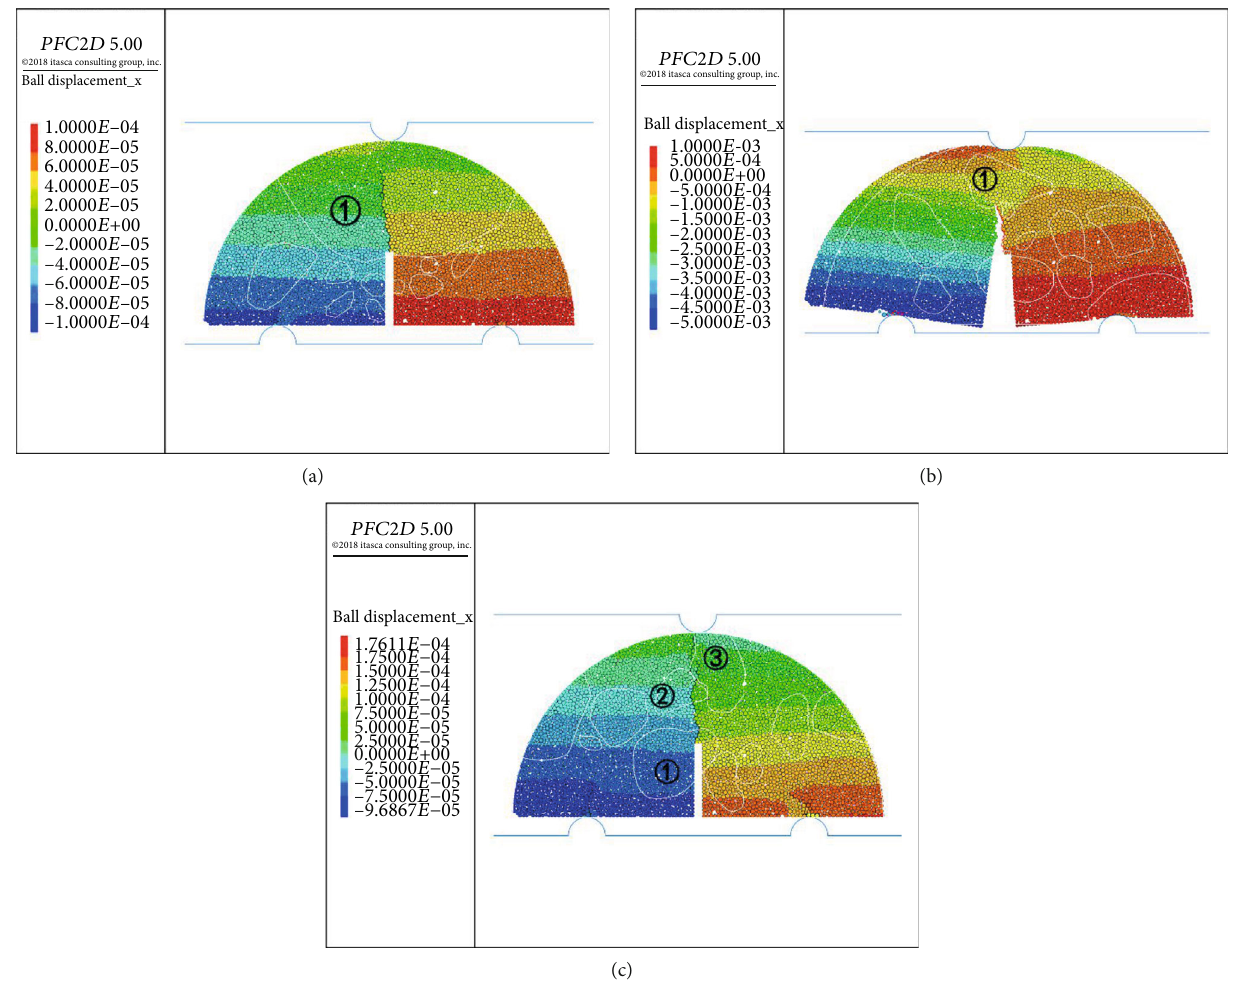
Figure 11: Simulation results of fracture toughness. Shown in the fi gure is the horizontal displacement of the three sets of simulation results; the right side is positive and the left is negative (Ball displacement_x). The black line segment above the prefabricated crack is the elements fracture produced during the loading process, which are the cracks generated during the fracture